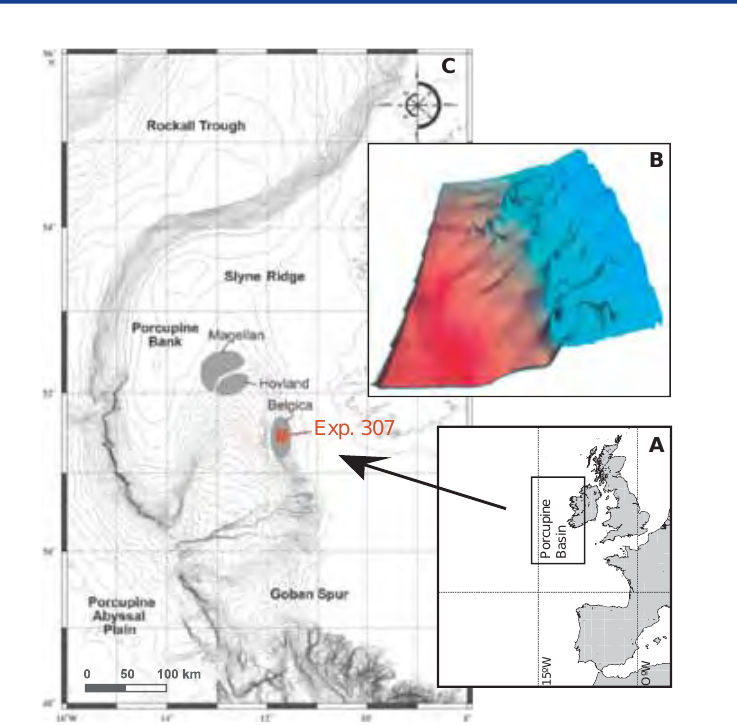
Figure 1. Location of Porcupine Seabight and IODP Expedition 307 operations area.